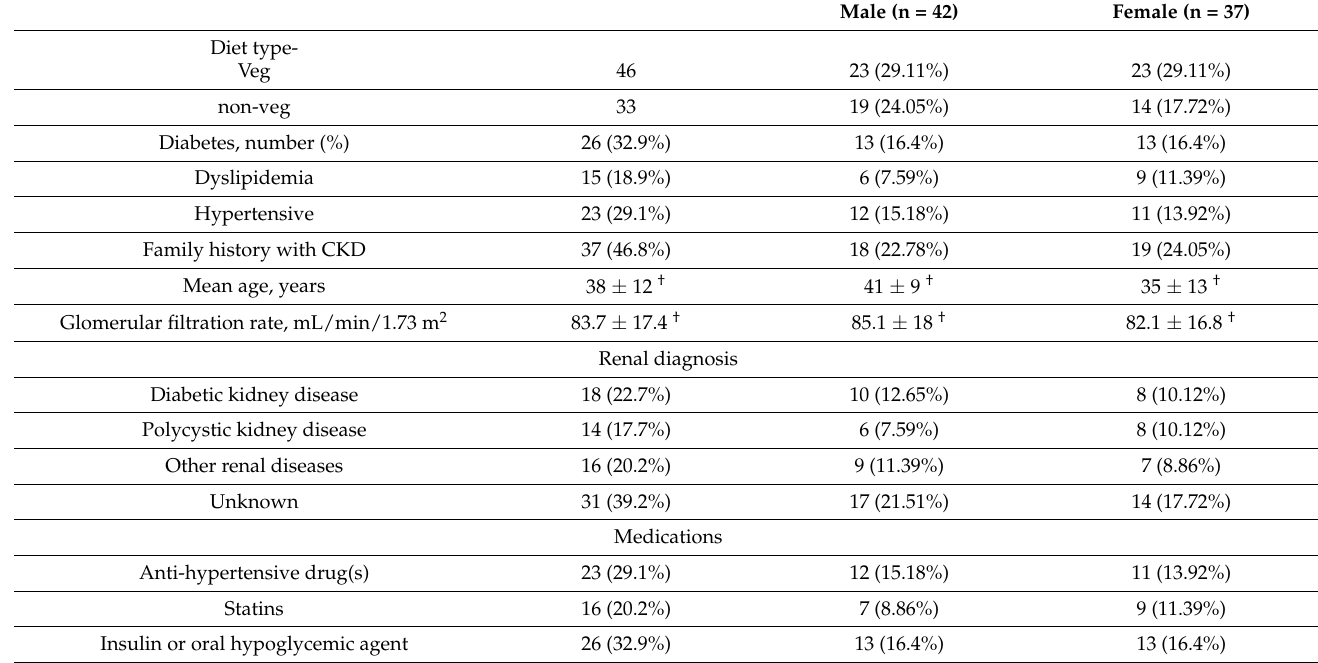
Table 2. Clinical characteristics of CKD patients (n = 79).